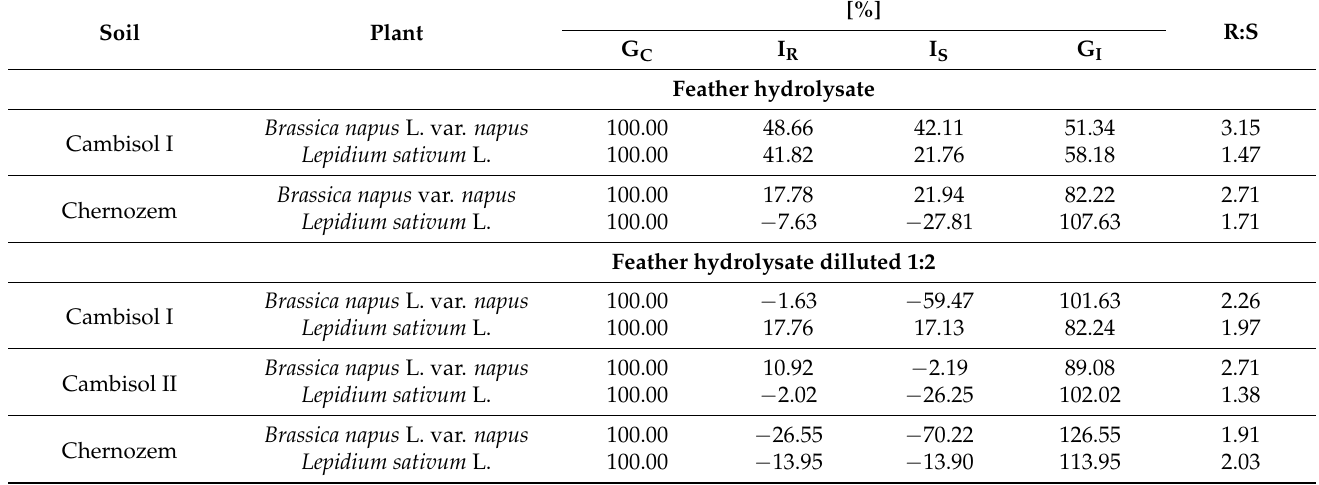
Table 1. Phytotoxicity of feather hydrolysates in soils with different physico-chemical properties.